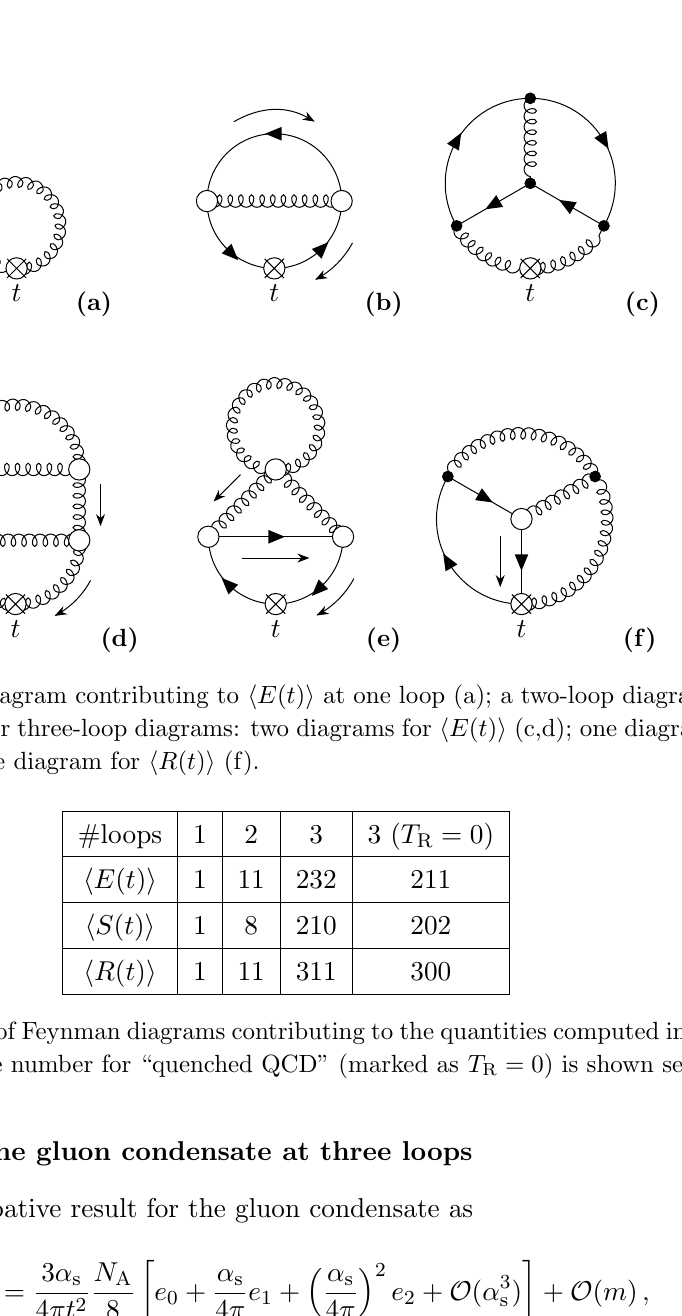
E ( t ) (c,d); one diagram for h i